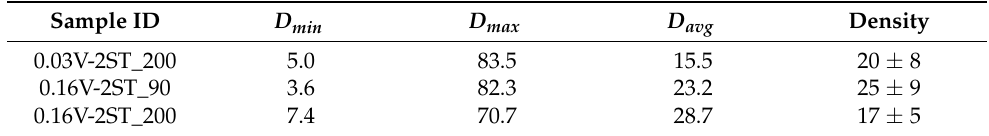
Table 4. Measured D min , D max , D avg (nm), and density of VC precipitates (number/ µ m 2 ) in Q&P-treated